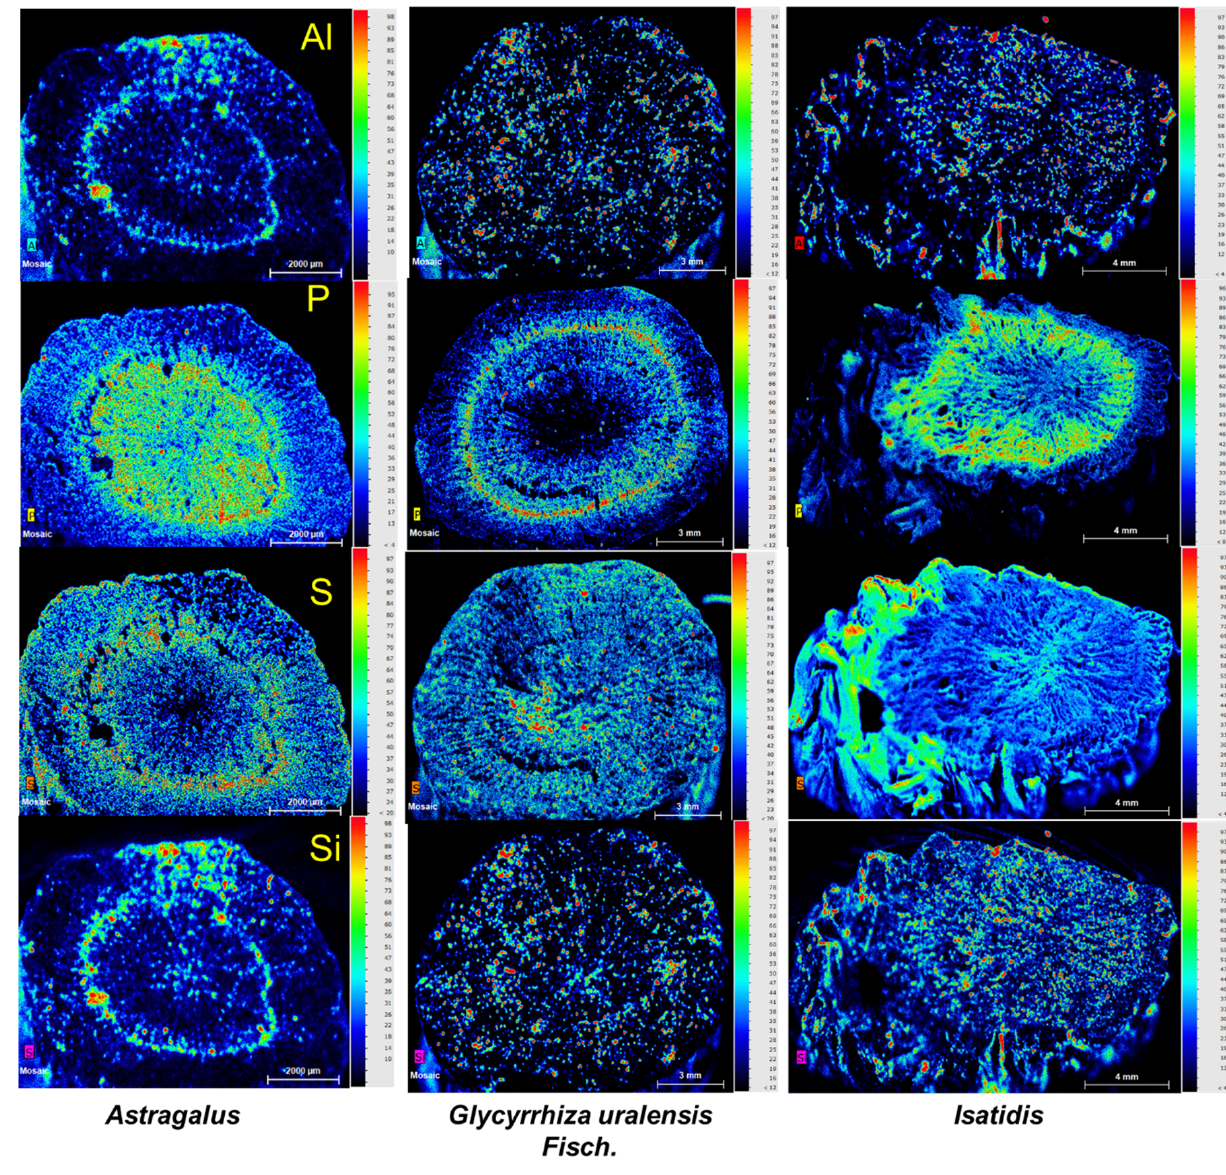
Figure 5. Distribution of Al, P, S, and Si on the three experimental herbal medicines, imaged using a µ-XRF spectrometer. Normalized X-ray fluorescence intensities are scaled from red (maximum) to blue (minimum) as indicated at the right.